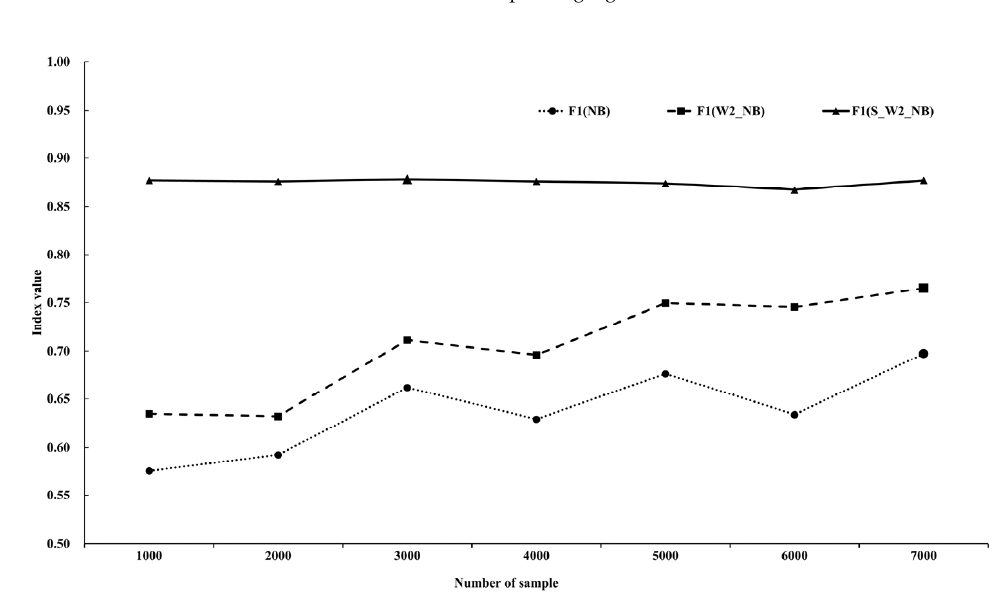
Figure 3. The index of comparison (F-score).